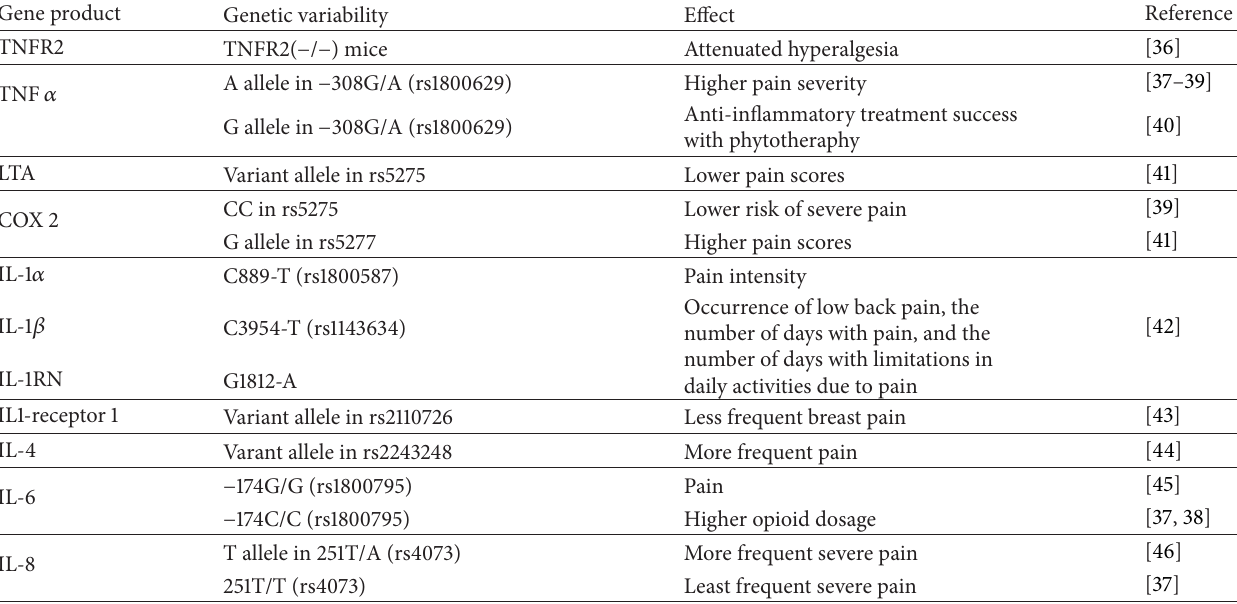
Table 3: Impact of genetic variability in genes for proinflammatory